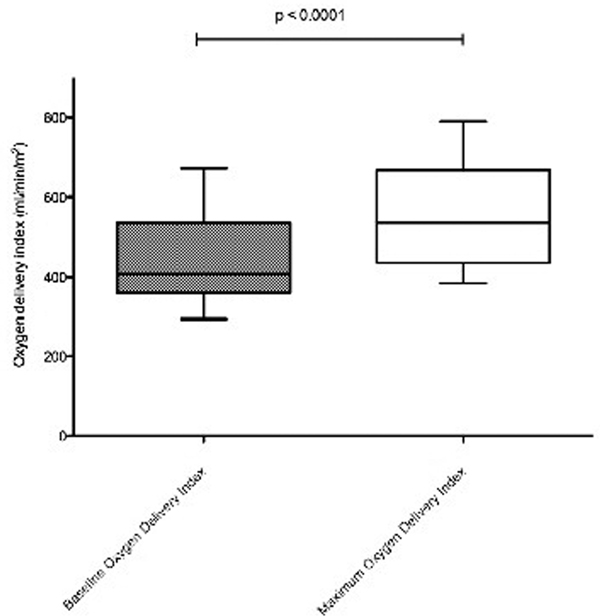
Increase in DO2I from baseline to maximum over the 8-hour protocol.